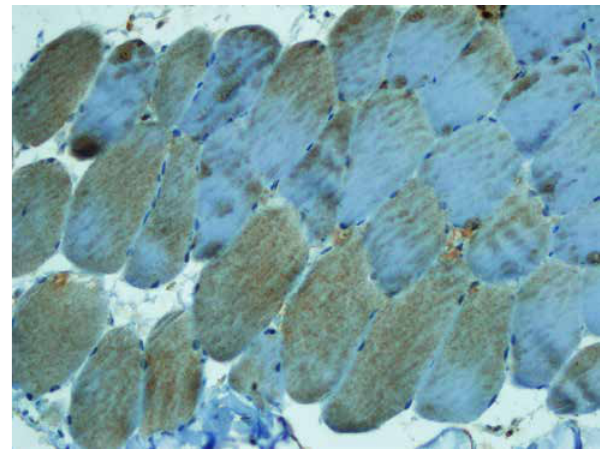
Figure 4. iNOS staining of hypothermia group was mild